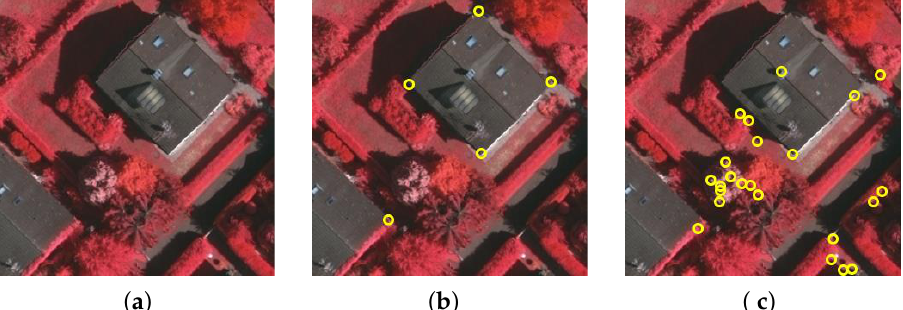
Figure 1. The problem to be solved in the present work: building corners in aerial images are hard to identify with existing generic corner detectors. ( a ) An aerial image for testing. ( b ) The ground-truth corner points (manually labeled). ( c ) Performance of a recently-proposed corner detection algorithm, the WEAE